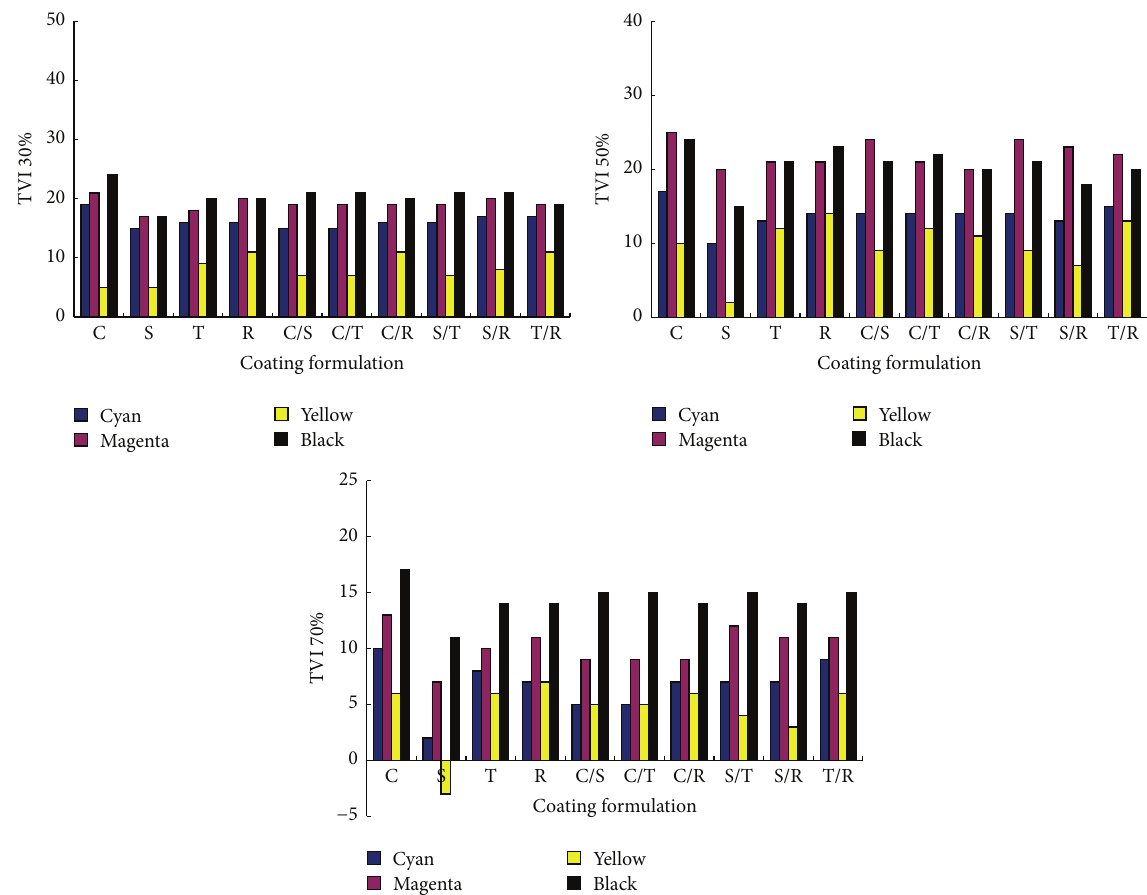
Figure 7: Effects of coating formulations on tone value increases (TVIs) of cyan, magenta, yellow, and black (CMYK) at 30%, 50%, and 70% dot coverage. C: CaCO 3 ; S: SiO 2 ; T: talc; R: sericite, with mixing ratios of